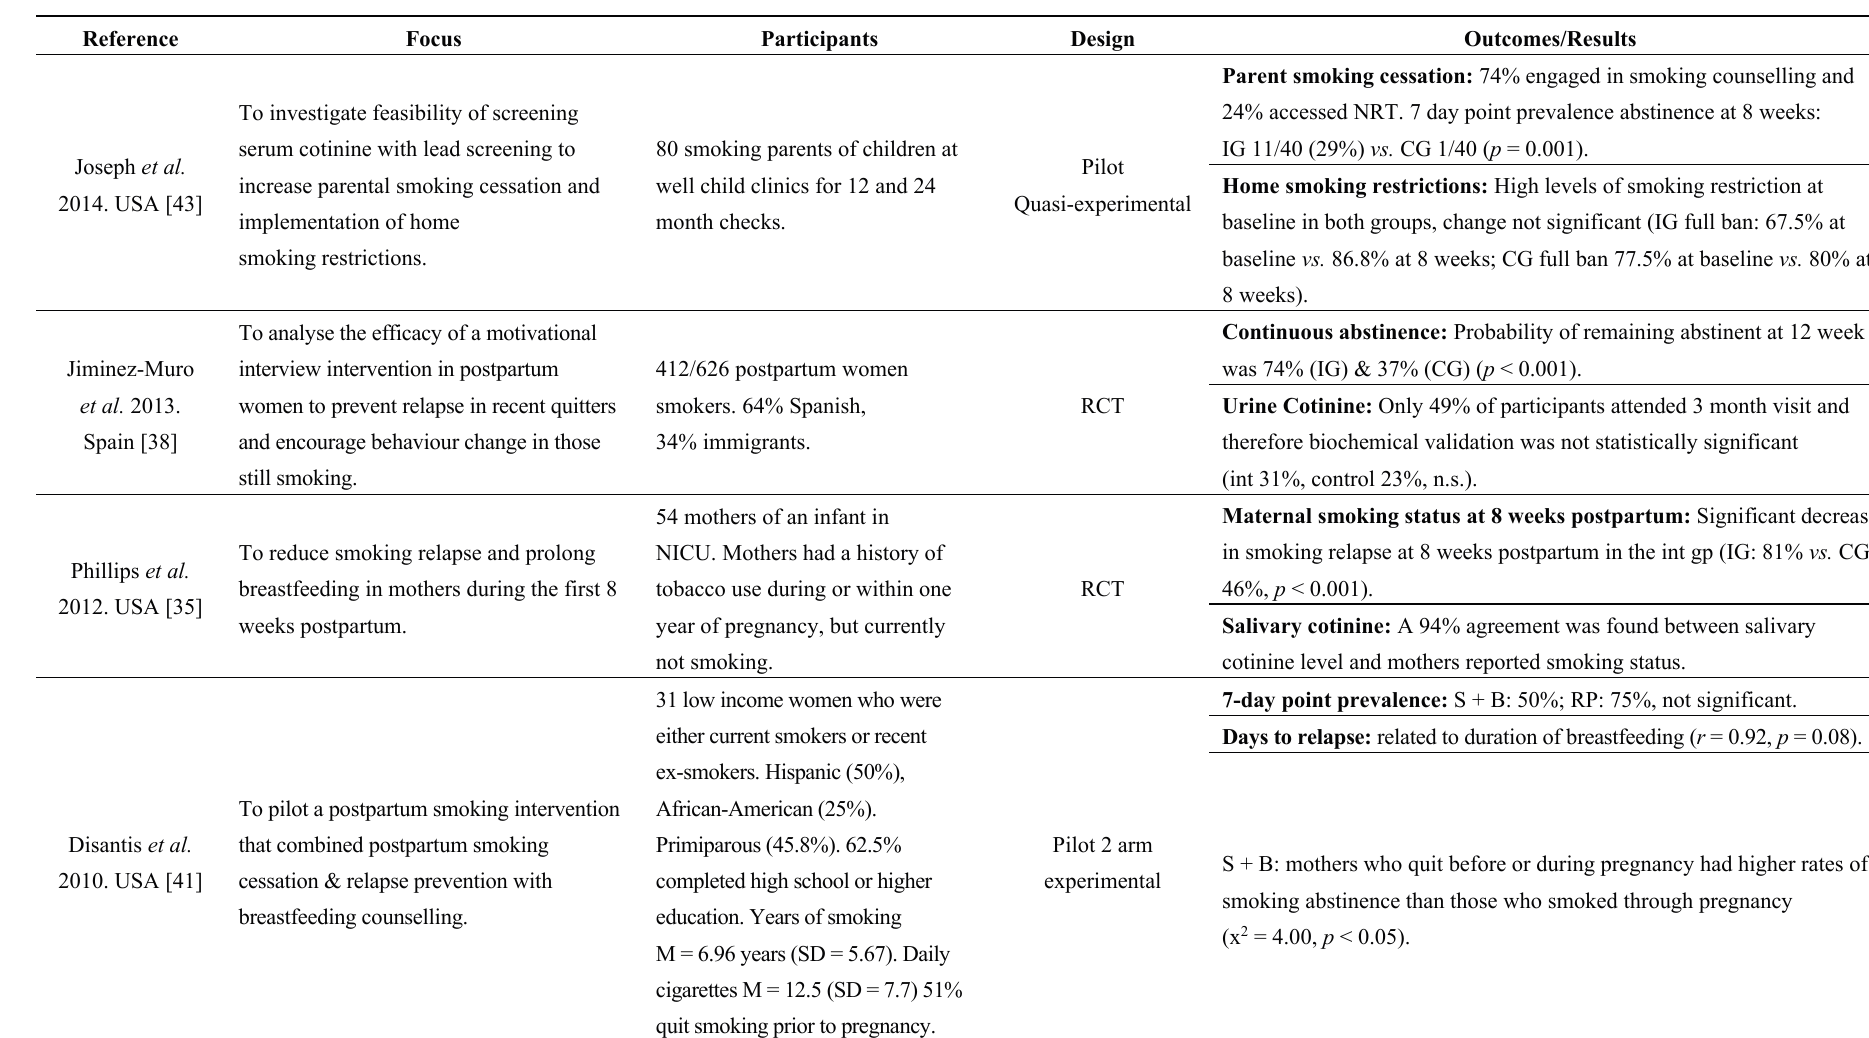
Table 3. Study designs and